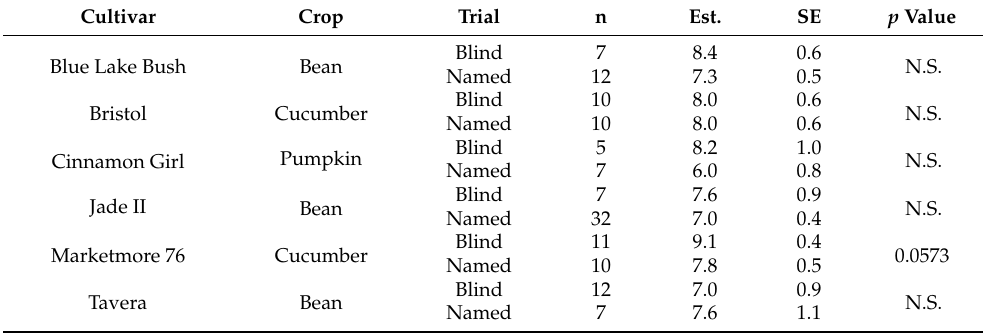
Table 11. Mean performance rating by trial (blind, named) within the cultivar in 2019 and 2020 trials. In named trials, seeds were labeled with cultivar names, while blind trials were assigned a code Performance was rated on a scale of 1 to 10, with 1 indicating poor performance and 10 indicating excellent performance. The number of participants who returned usable data for each cultivar is reported as “n”. Mean separation was performed using Fisher’s Protected LSD with an alpha level of p <